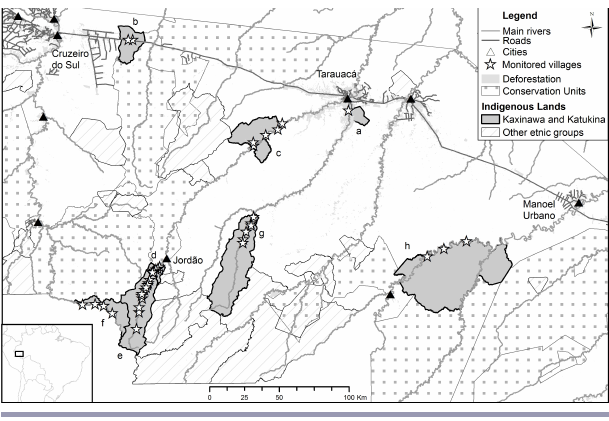
Fig. 1 . Kaxinawá and Katukina indigenous lands studied in Acre State, Brazilian Amazon. Indigenous lands’ labels: (a) Kaxinawá do Igarapé do Cauho, (b) Katukina do Campinas, (c) Kaxinawá da Praia do Carapanã, (d) Kaxinawá do Baixo Rio Jordão, (e) Kaxinawá do Rio Jordão, (f) Kaxinawá/ Ashaninka do Rio Breu, (g) Kaxinawá do Humaitá, and (h) Alto